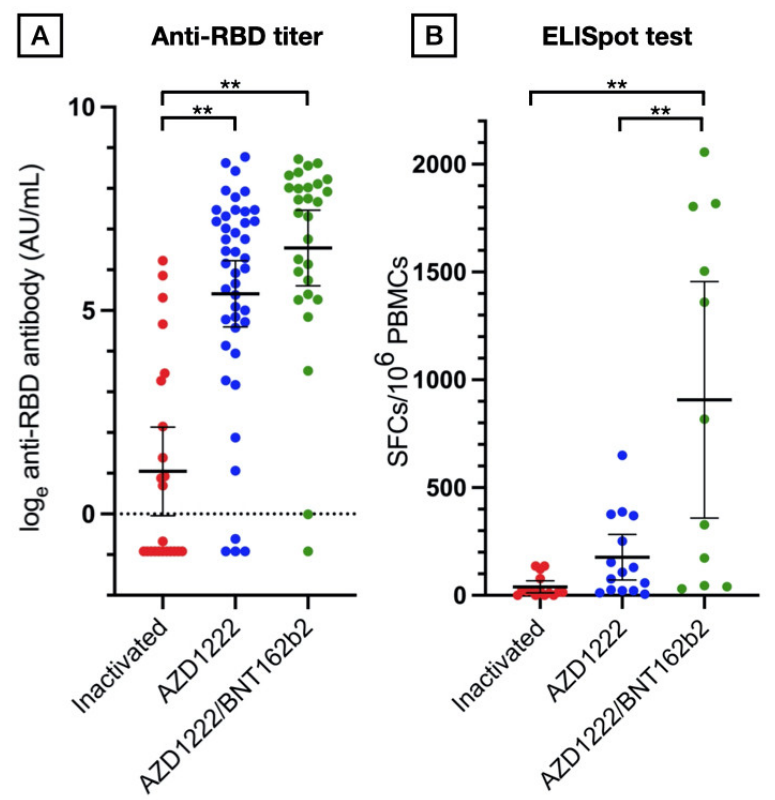
Figure 1. Immunogenicity assessment stratified by vaccine group. ( A ) Scatter plot of natural log- transformed total immunoglobulin specific to the receptor-binding domain (RBD) in inactivated, AZD1222, and AZD1222/BNT162b2 vaccine groups after two doses. ( B ) Scatter plot of spot-forming cells (SFCs)/10 6 peripheral blood mononuclear cells (PBMCs) after a two dose completion stratified by vaccine group. Data points are the reciprocals of the individual. Line indicates mean and bar indicates 95% confidence interval. ** indicates p < 0.001.